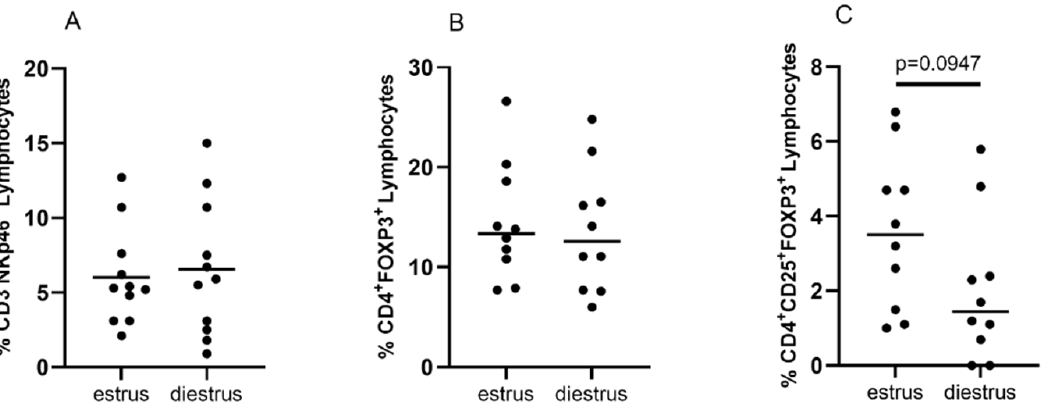
Figure 2. Comparison of the percentage of CD3 - NKp46 + , CD4 + FOXP3 + and CD4 + CD25 + FOXP3 + en- dometrial lymphocytes between estrus and diestrus in 11 mares. There were no significant differ- ences between CD3 - NKp46 + lymphocytes and CD4 + FOXP3 + lymphocytes in estrus and diestrus ( p > 0.05 ( A , B ). The percentage of CD4 + CD25 + FOXP3 + lymphocytes was higher in estrus than diestrus ( p = 0.0947) ( C ). Analysis with paired two-tailed Student’s t test was performed in GraphPad Prism v. 9.0.